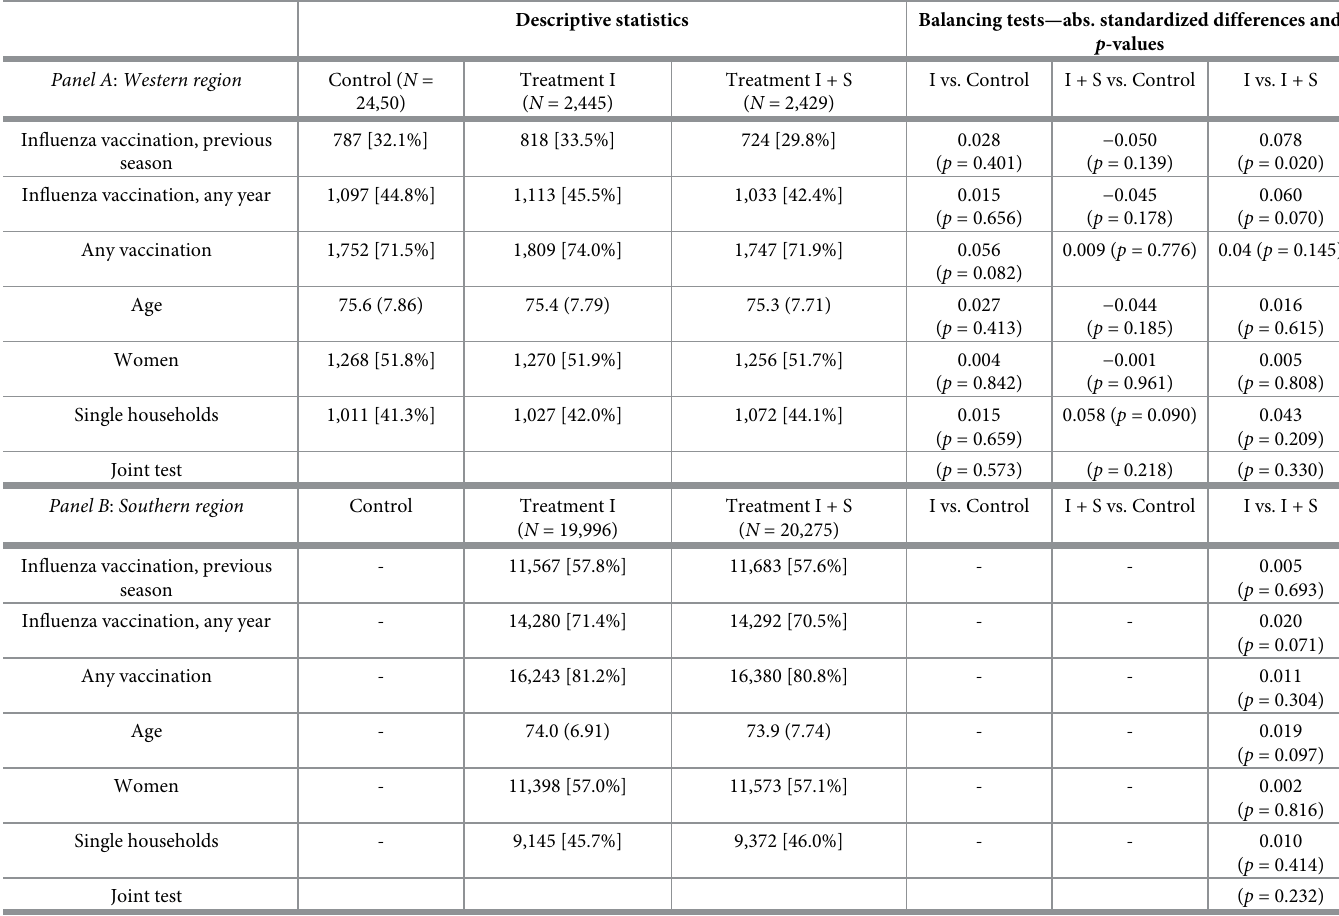
Table 1. Summary statistics by study region and treatment (analysis sample).